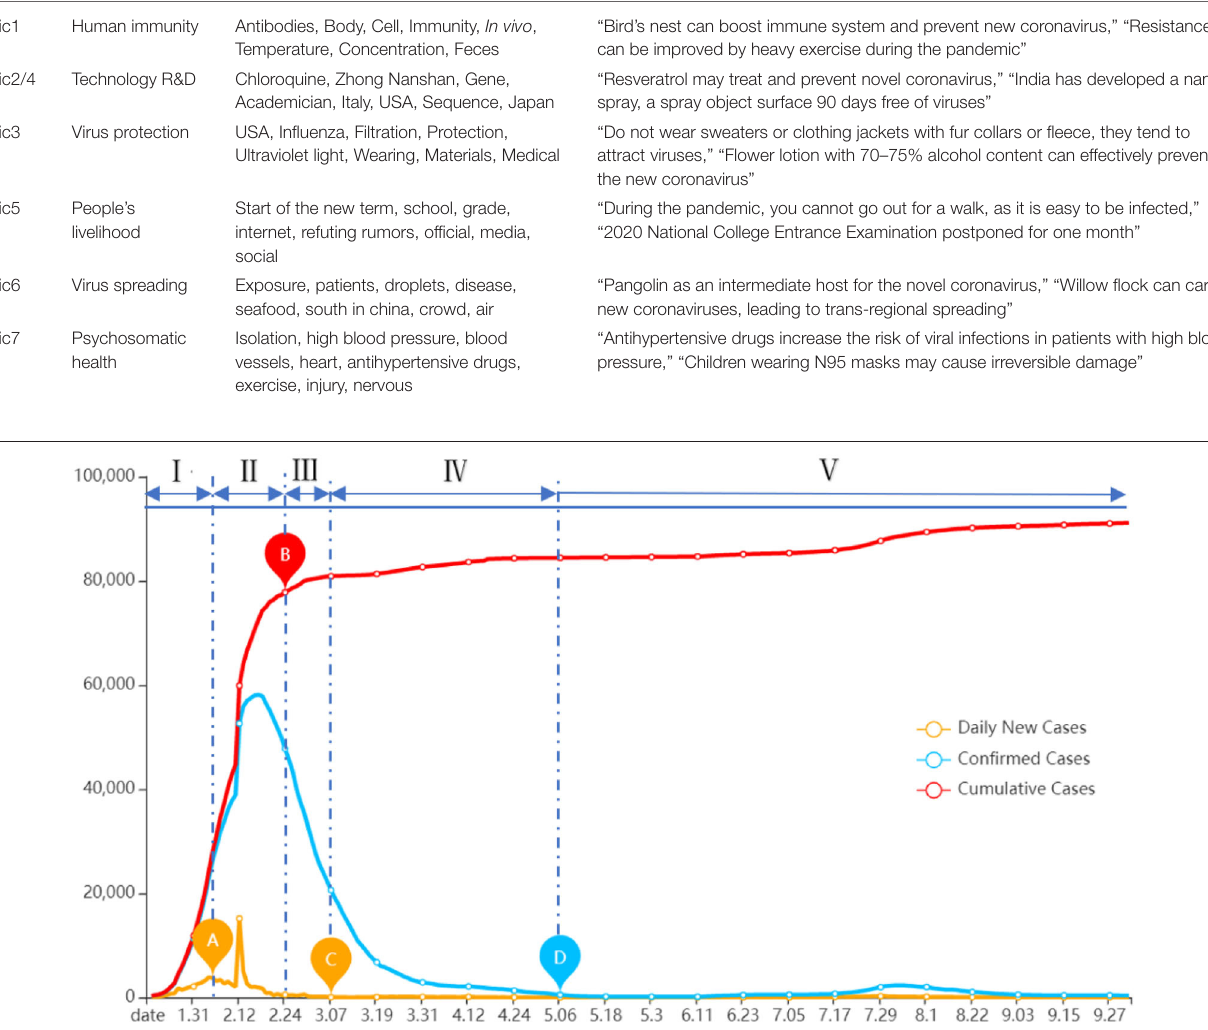
FIGURE 7 | Data on progress of the COVID-19 pandemic in